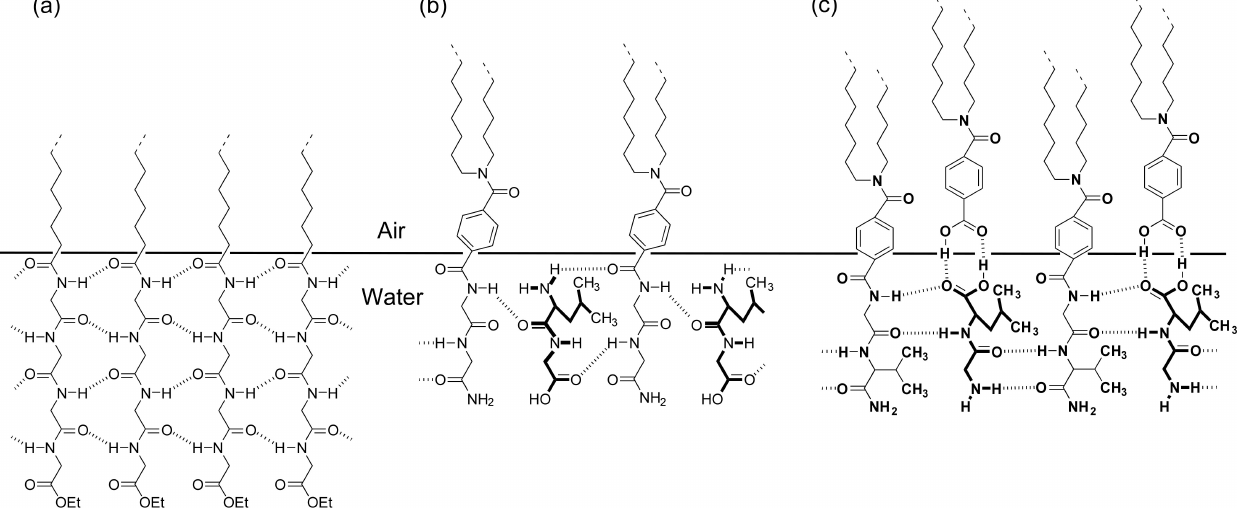
Figure 2. Various types of peptide-functionalized monolayer for molecular recognition of aqueous dipeptides (see text for details). Reprinted with permission from [30] ©1996, American Chemical